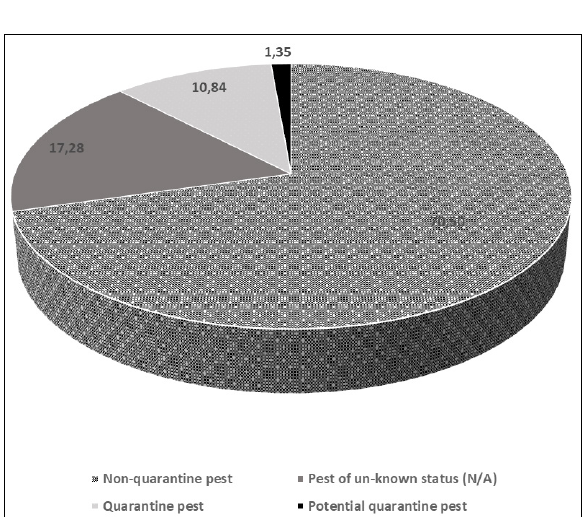
Figure 1: Categories of intercepted organisms ( n =341) in South Africa, 2011–2019.